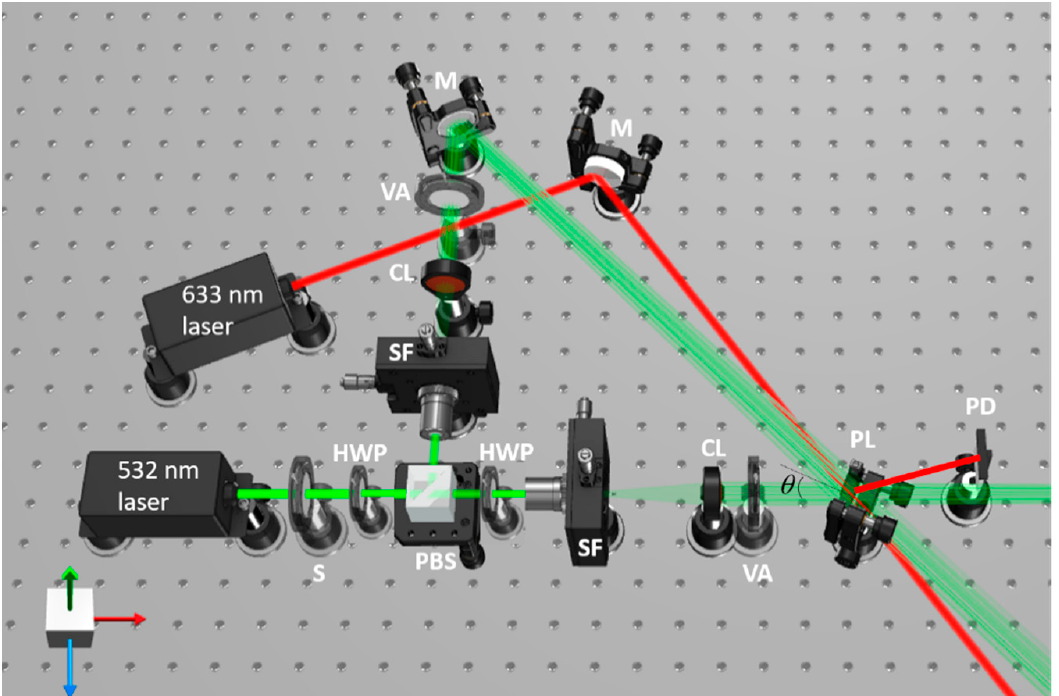
Figure 1. Experimental set-up for holographic recording of transmission gratings using a 532 nm laser. Monitoring of the diffraction efficiency growth curve is performed by probing with a 633 nm laser and collecting beam intensity data with a photodetector positioned at the diffracted beam path. S—electronic shutter, HWP—half-wave plate, PBS—polarising beam splitter, SF—spatial filter, CL—collimator, VA—variable aperture, PL—PHSG layer, M—mirror,